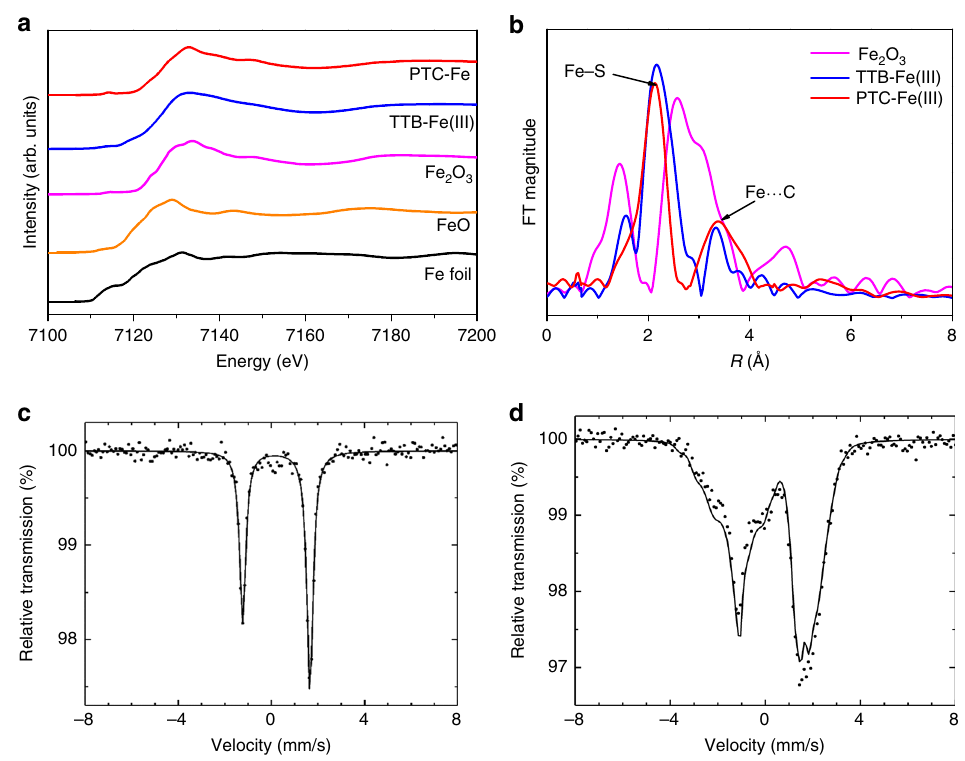
Fig. 2 Compositional characterizations of PTC-Fe. a Normalized XANES spectra at the Fe K -edge of PTC-Fe and its reference compounds, including Fe foil, FeO, Fe 2 O 3 , and 1,2,4,5-tetrathiolbenzene-Fe(III) (TTB-Fe(III)). For the PTC-Fe, the energy of adsorption edge (E0) suggests that the valence state of the Fe ion in the PTC is 3 + . b Fourier transform of the EXAFS at Fe K-edge of PTC-Fe as well as Fe 2 O 3 and TTB-Fe as the contrast samples. c , d 57 Fe Mössbauer spectra at 294 K and 5 K, respectively. Dots and black line correspond to experimental data and calculated spectrum,